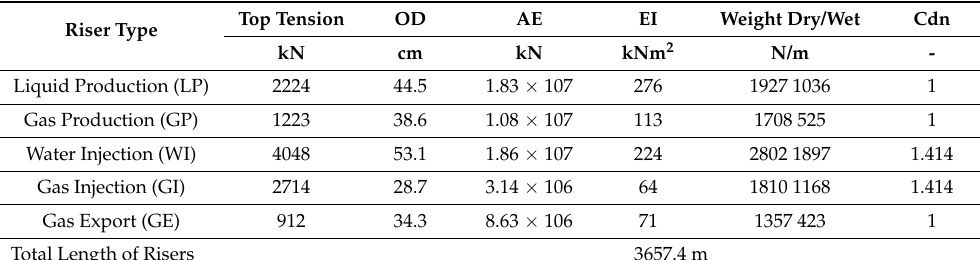
Figure 12. Arrangement and Numbering of the FPSO Risers. Table 6. Riser Particulars.